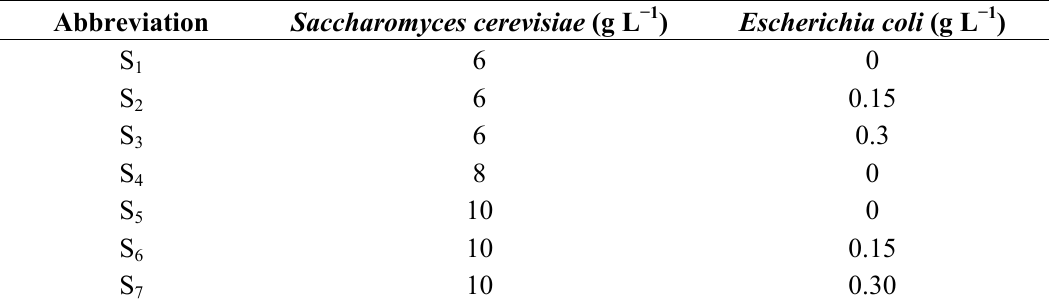
Table 1. Summary of the suspensions prepared for microfiltration